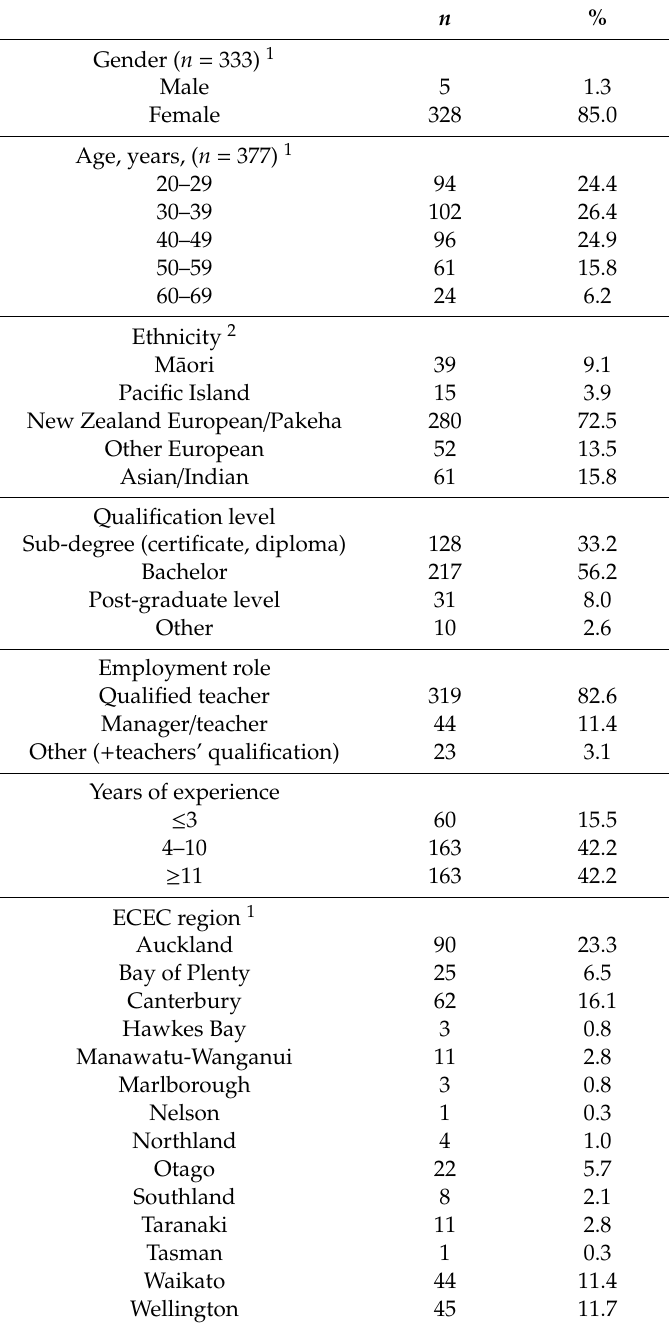
Table 1. Participant characteristics ( n =